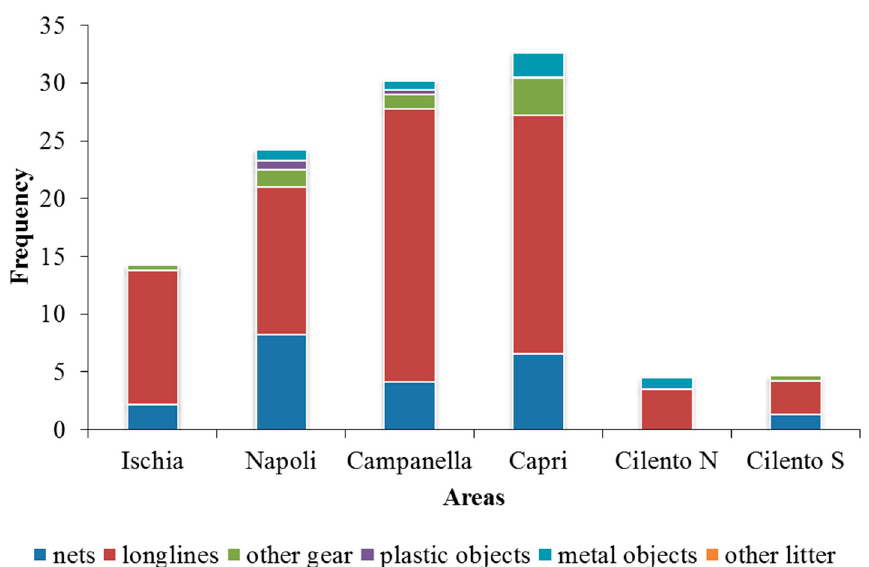
Figure 8. Frequencies composition of fishing gear and marine litter in each area. Anthropogenic impact types direct (BUC = broken/upturned colonies and GCE = gears covering/entangling), and indirect (CNE = colonies with necrosis/epibiosis) are shown in Figure